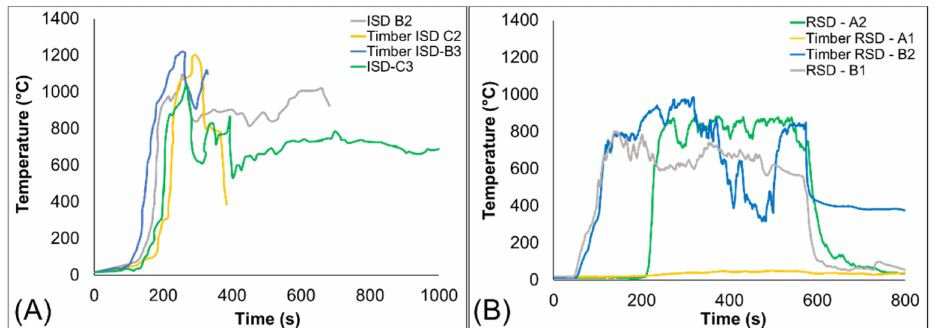
Figure 13. Ceiling temperature of 4 Nos RSDs in ( A ) FSEs, and ( B )